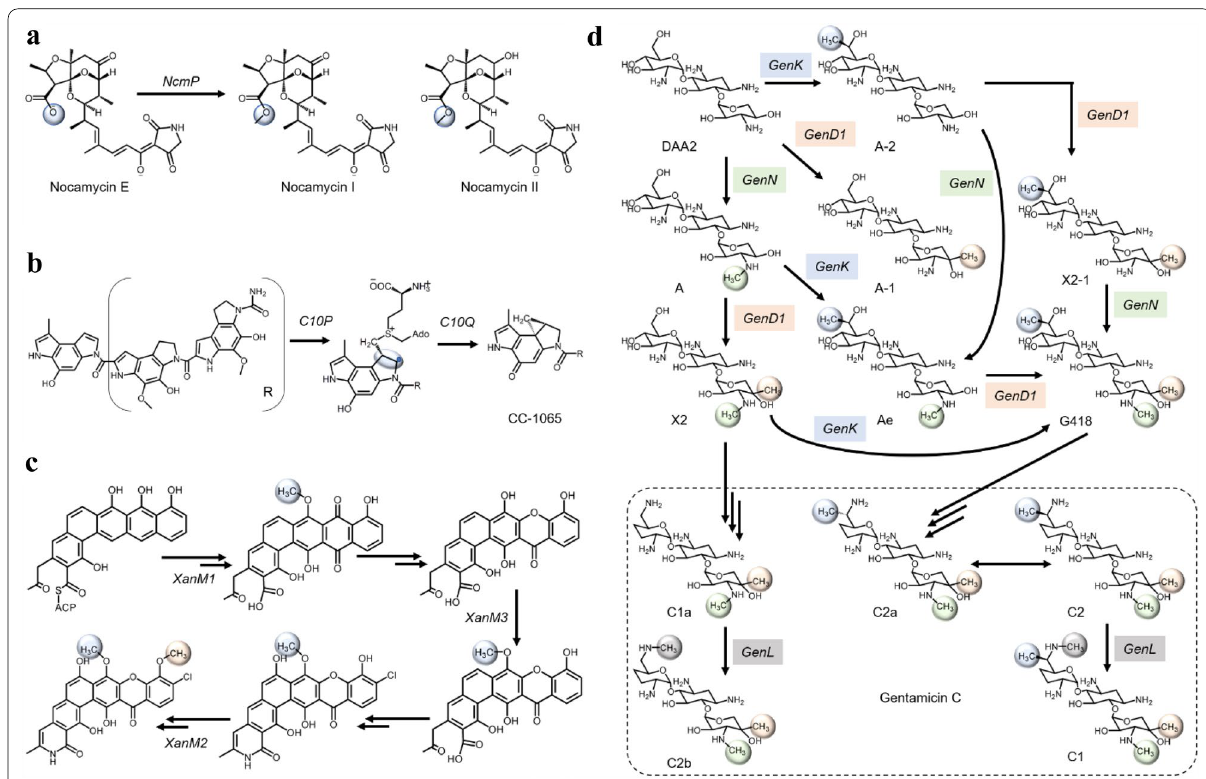
Fig. 2 Reactions of recently discovered novel methyltransferases. These enzymes are mainly discovered through genomic and chemical screening (Table 1). a Methylation of nocamycin E by NcmP to produce nocamycin I. The structure of Nocamycin II is shown. b Novel radical-SAM mediated cyclopropanase system to produce the antibiotic CC1065. c Network of methyltransferases involved in xantholipin biosynthesis. d Network of methyltransferases involved in gentamicin C biosynthesis. The starting compound is 3-dehydro-3-oxo-gentamicin A2